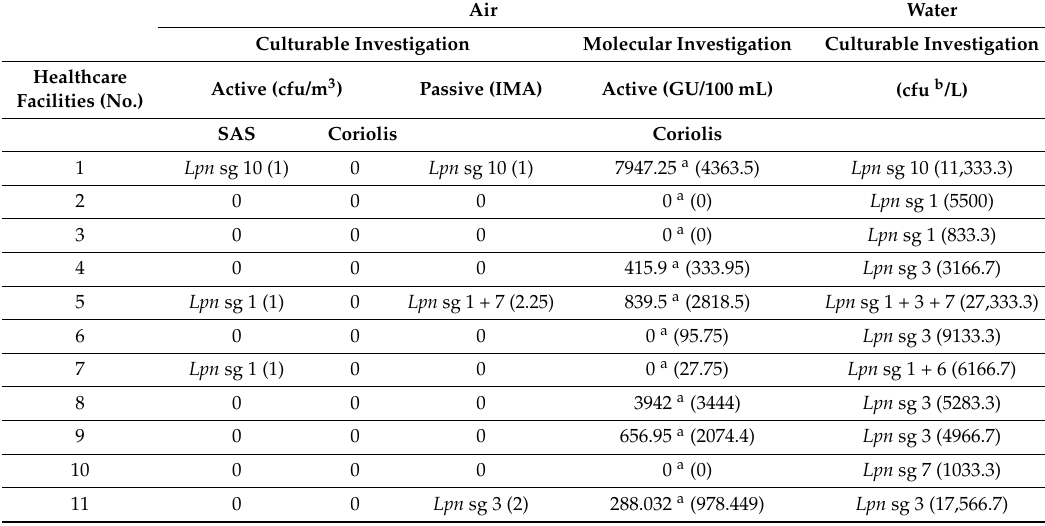
Table 1. Legionella from air and water samples by culturable and molecular investigations. Air Water Culturable Investigation Molecular Investigation Culturable Investigation Healthcare Facilities (No.)